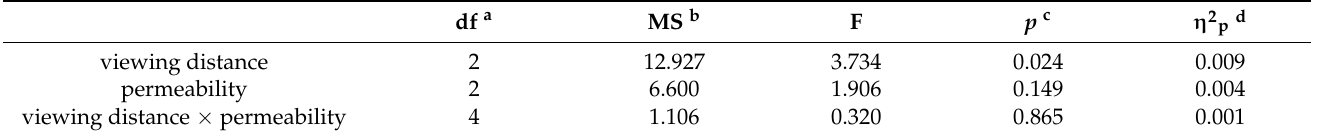
Table 12. Impacts of different viewing distances and permeability levels on perceived preference.